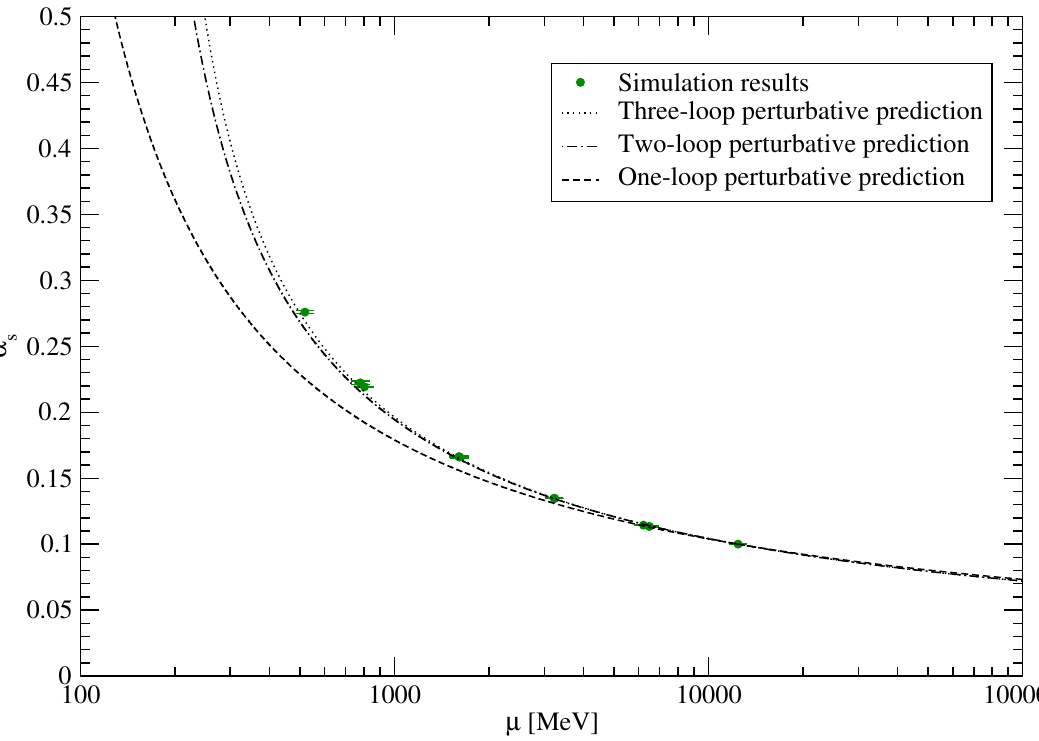
Figure 8 . Running coupling (cid:11) = g 2 = (4 (cid:25) ) in SU(3) Yang-Mills theory, plotted against the mo- s mentum scale (cid:22) = 1 =L . The dashed, dash-dotted, and dotted curves represent the perturbative predictions at one, at two, and at three loops,